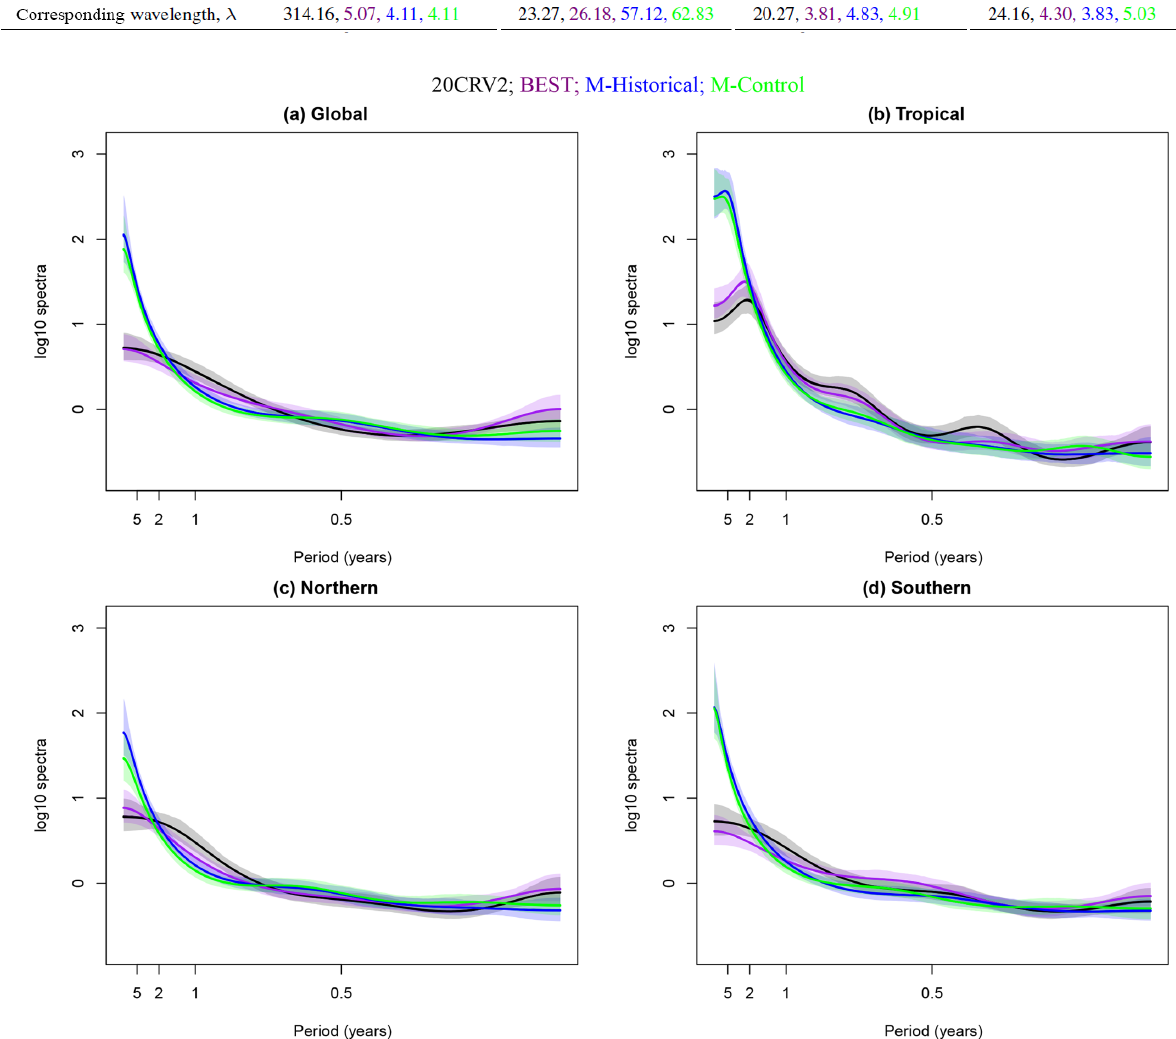
Figure 8. Same as in Fig. 4 but for the long-term analysis.